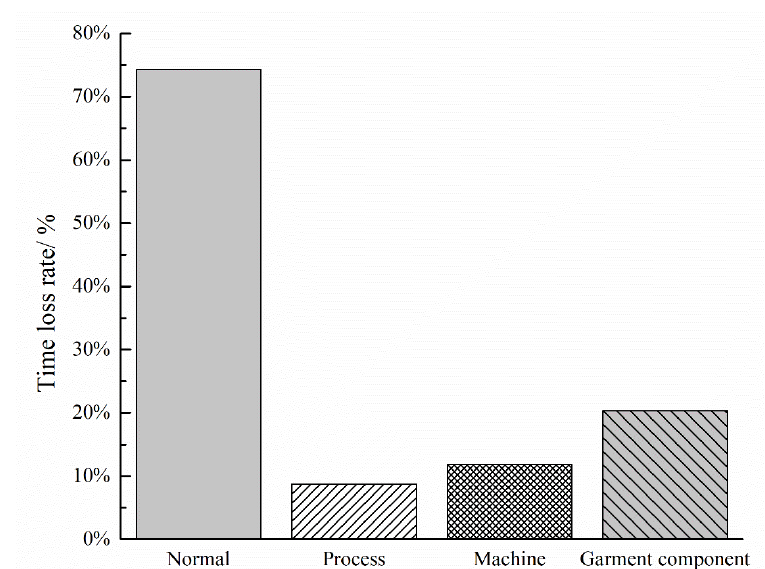
Figure 9. Time loss rate of assembly lines under different workstation layouts.